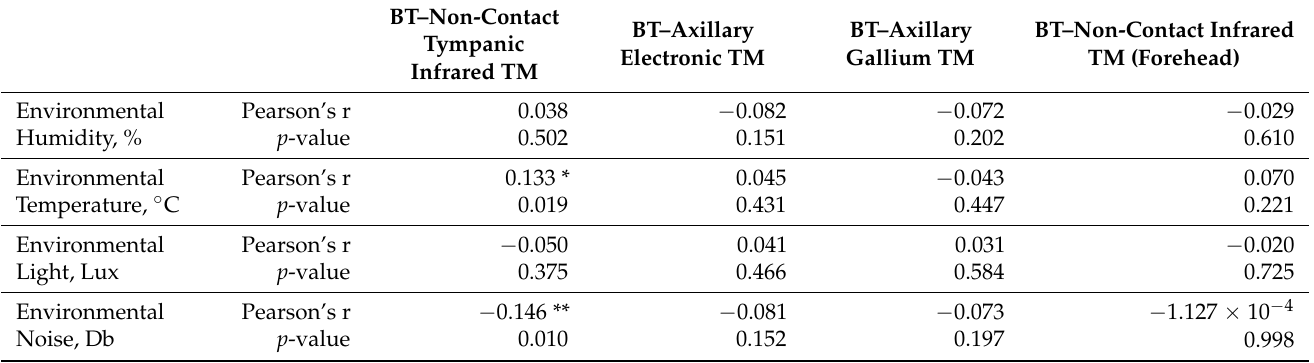
Table 10. Correlations: environmental variables and body temperature with different